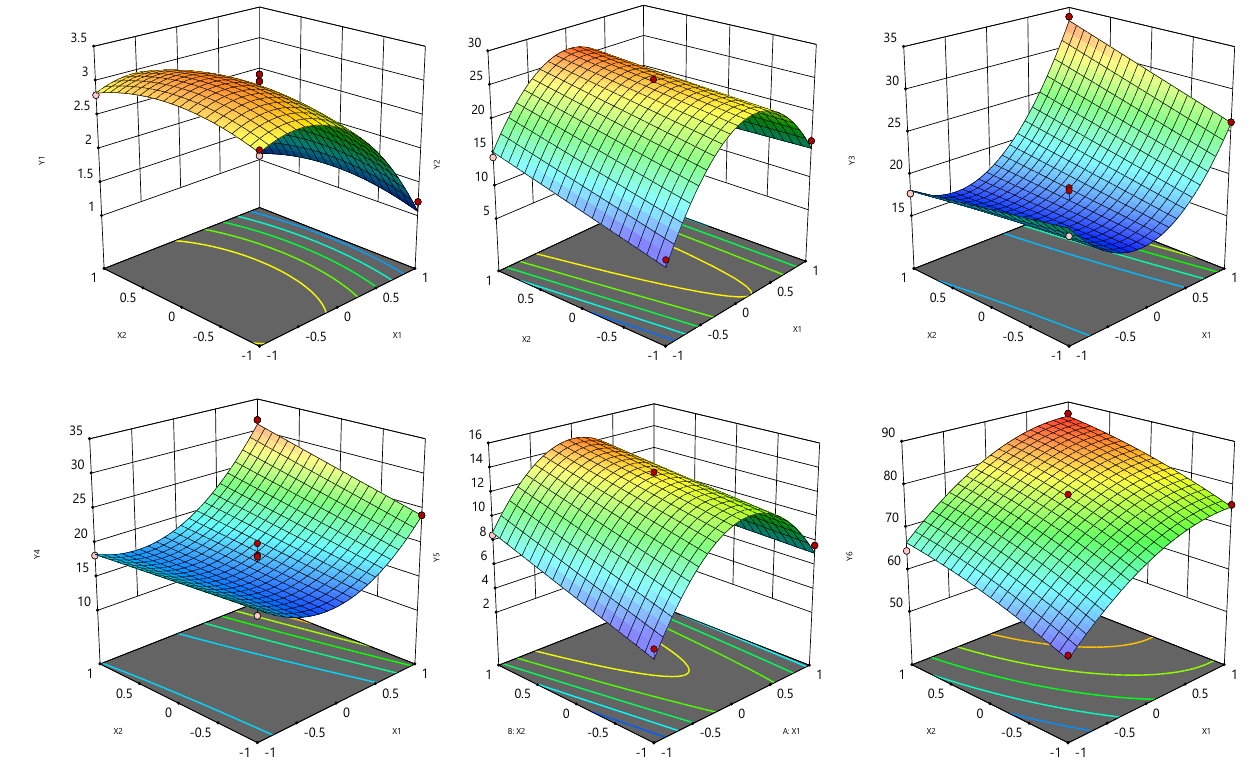
Figure 14. The response of the main variable to process factor variations.